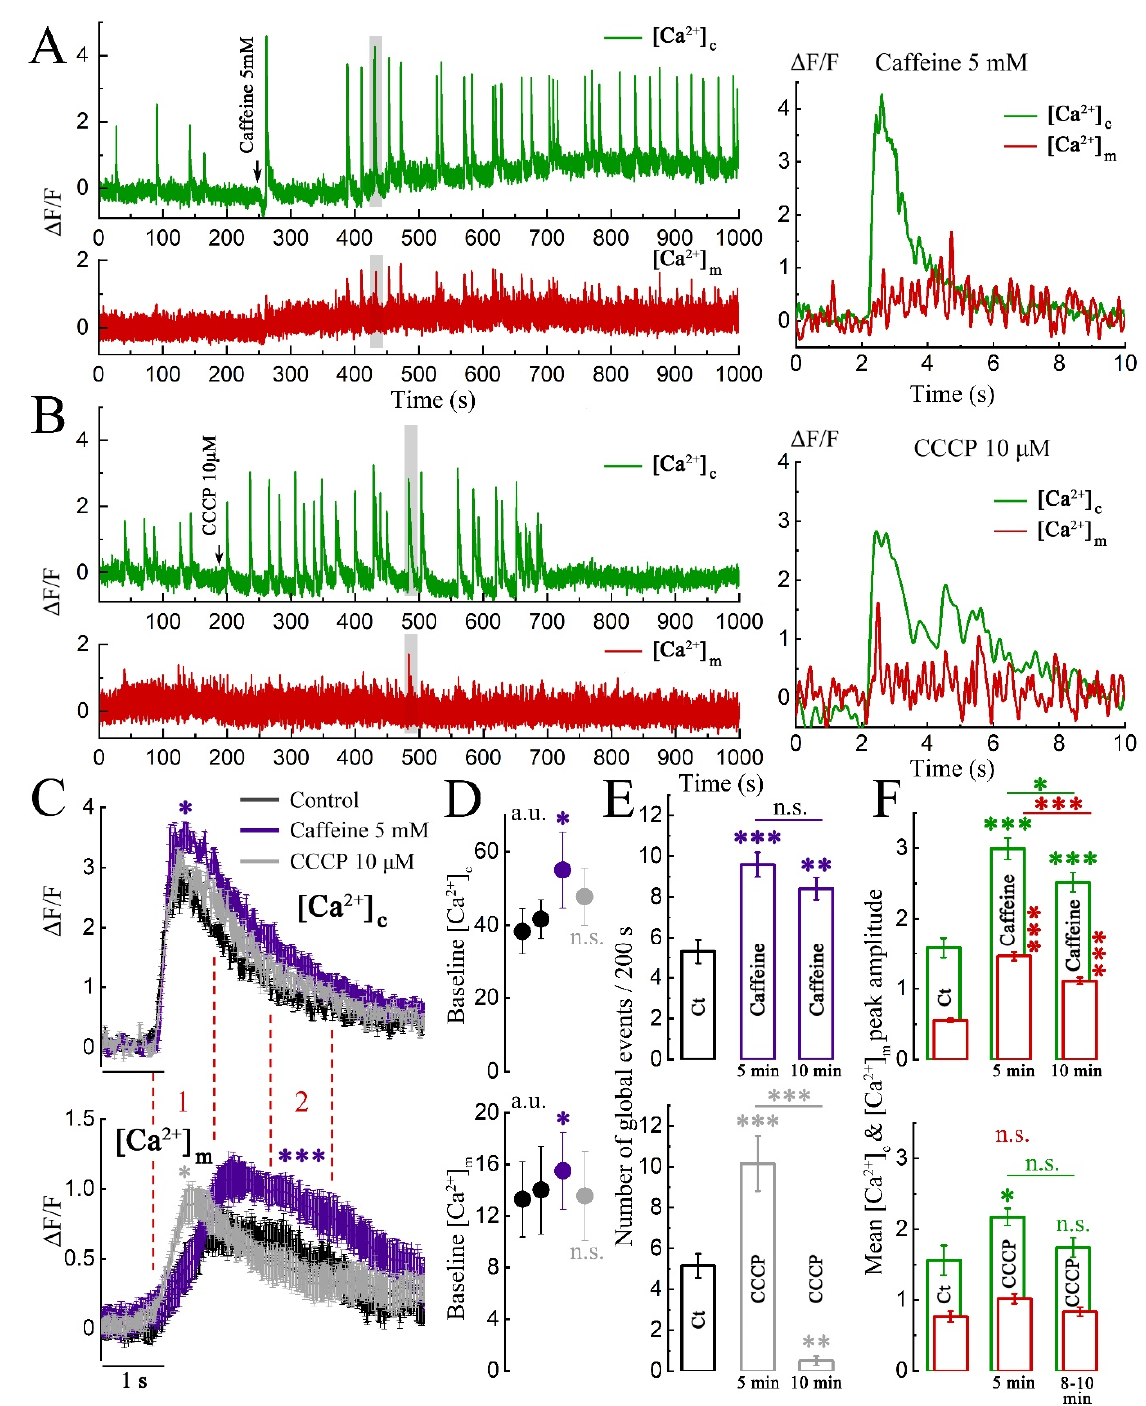
Figure 3. Impact of caffeine and CCCP on the kinetics of mitochondrial calcium responses associated with global events in cytosolic calcium. ( A ) Sample recording in caffeine (5 mM). Cytosolic calcium (Fluo-2) is shown in green, mitochondrial calcium (mtRCaMP) in red. ( B ) Sample recording in CCCP (10 µM). The gray areas from panels ( A ) and ( B ) are enlarged on the right, colors are the same as for ( A ). ( C ) Averages of global [Ca 2+ ]c in multiple dendritic regions (top) and the corresponding [Ca 2+ ]m (bottom). Control: 8 cells, 16 clusters, 2 cultures; caffeine: 4 cells, 12 clusters, 2 cultures; CCCP: 4 cells, 12 clusters. 2 cultures. An equivalent number of global events was averaged for each cluster. Normalized fluorescence at two time periods (each 1 s long) within two dashed red lines, marked 1 and 2, were compared. 1—comparison of [Ca 2+ ]m during the [Ca 2+ ]c peak: control vs. CCCP and caffeine vs. CCCP, p < 0.05, control vs. caffeine-n.s.; 2—comparison of [Ca 2+ ]m during [Ca 2+ ]c decay: control vs. CCCP vs. caffeine, p < 0.001; ANOVA, F (period 1) = 93.39, F (period 2) = 628.76, post hoc